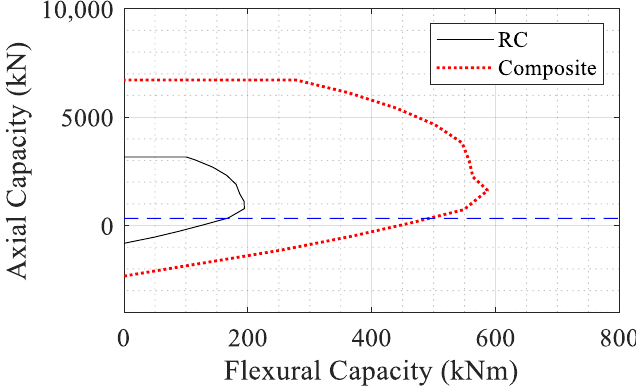
Figure 11. Interaction diagrams for RC and composite column sections.